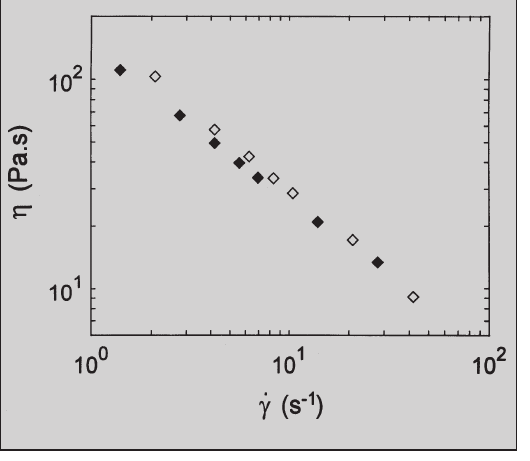
Figure 2 (right): Dependence of the shear stress, τ , on the shear rate, γ · , for the suspension in sili- cone oil SO 350 (Electric field: DC (a), 50 Hz AC (b); Field strength (kV/mm):